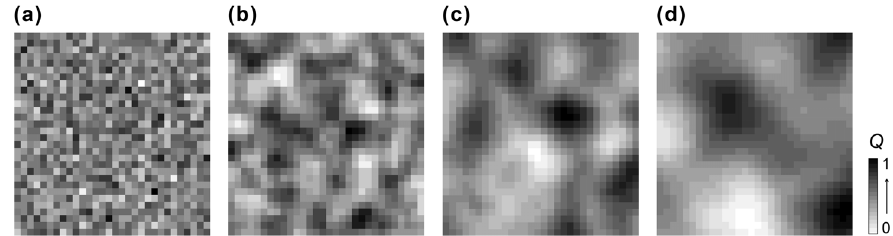
Figure 4. Examples of artificial landscapes differing in the scale of spatial autocorrelation in habitat quality S . (a) nearly random, S =0.01; (b) small-scale, S =2; (c) intermediate-scale, S =4; and (d) large-scale, S =8. The mean habitat quality of the landscapes is fixed at